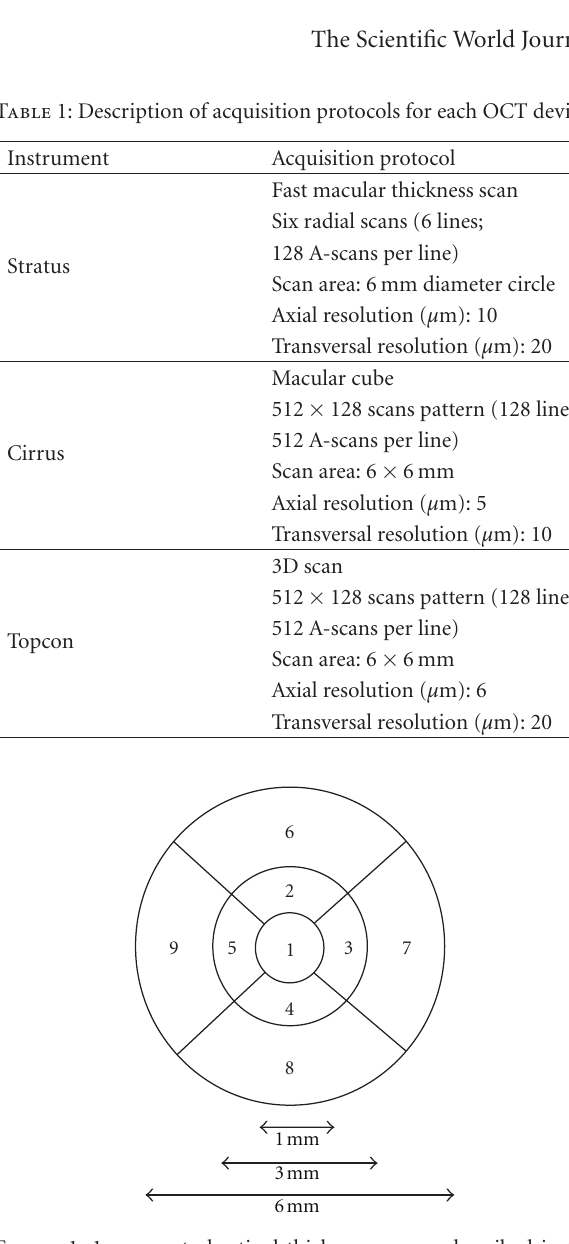
Figure 1: 1mm central retinal thickness area as described in the Early Treatment Diabetics Retinopathy Study